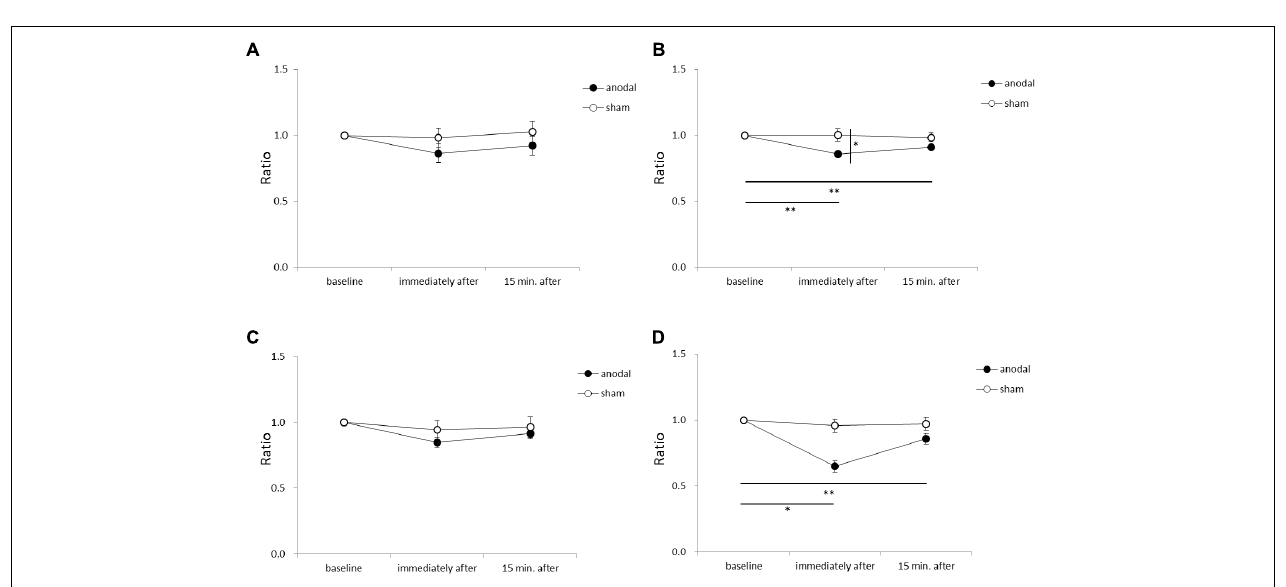
FIGURE 4 | Serial changes in average acceleration and maximum acceleration in the y -axis before, immediately after, and 15 min after anodal or sham tDCS over the SMA. (A) Normalized values of average acceleration in the y -axis. (B) Normalized values of maximum acceleration in the y -axis. All data reflect the mean ± standard error of the mean.